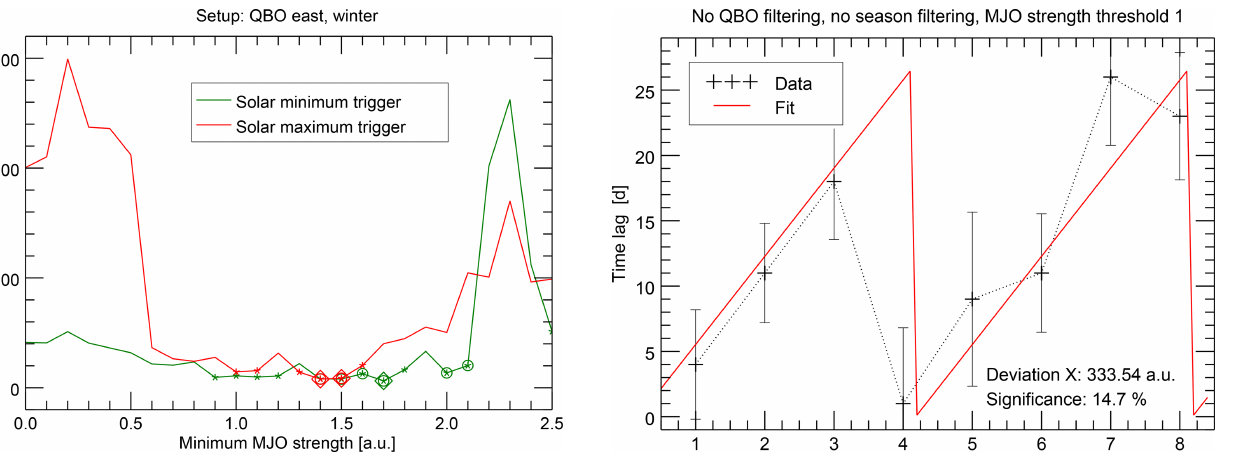
Figure 9. As in Fig. 4, but showing results of an experiment with- out filtering for QBO phase and season. As described in the text, the results are not significant anymore on a level better than 10%. However, it is visually seen in this figure that there are still indica- tions for the sawtooth-like pattern instead of a totally unstructured